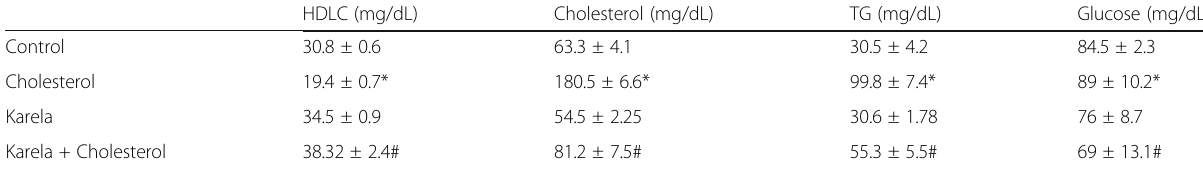
Table 2 Protective effects of Karela on hypercholesterolemia induced changes in serum lipid levels in Wistar